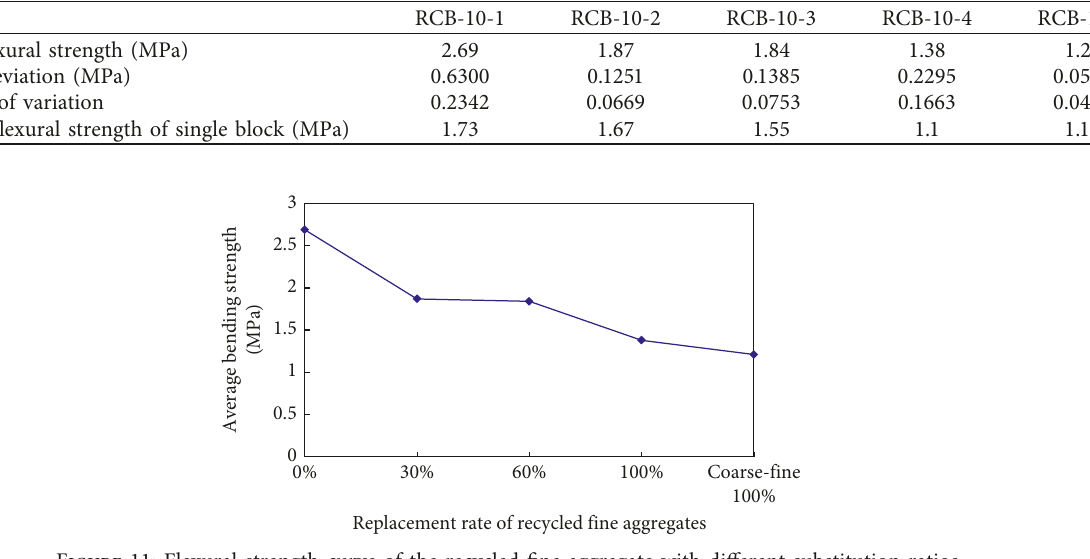
Figure 11: Flexural strength curve of the recycled fine aggregate with different substitution ratios. Table 11: Summary of the test results of flexural strength of recycled blocks with different substitution rates of MU7.5. Block